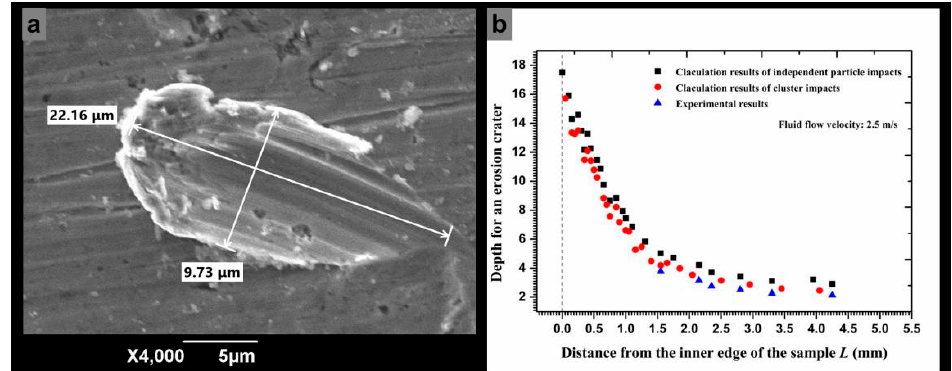
Figure 10. Velocity components of a particle in Particle Layer I along the radial surface. ( a ) Normal impact velocities; ( b ) Tangential impact velocities.